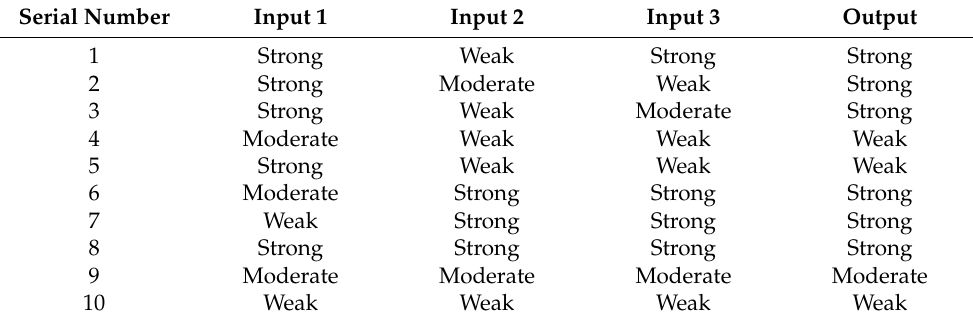
Table 1. Spatial correlation rules of fuzzy systems A and B.